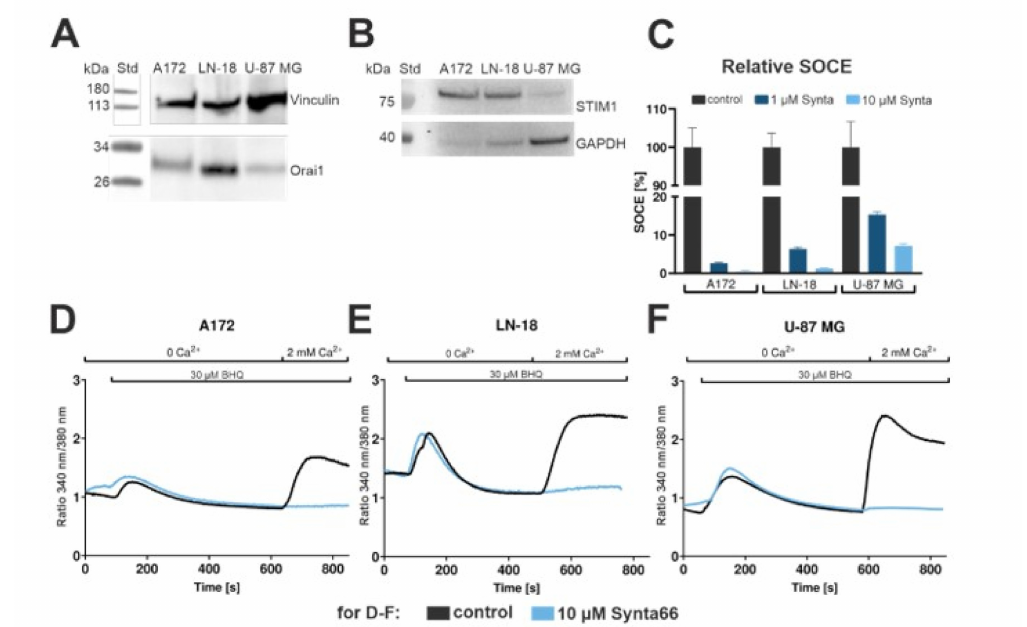
Figure6. InhibitionofSOCEinGBMcelllinesbySynta66: ( A )Westernblotfordetectionofendogenously expressed Orai1 in lysates of A172, LN-18 and U-87 MG cells. Lysates were deglycosylated in order to achieve a single Orai1 band as in [51]. ( B ) Western Blot for detection of endogenously expressed STIM1 in lysates of A172, LN-18 and U-87 MG cells. ( C ) Normalized maximal values of SOC activation from Fura-2 AM loaded GBM cells (A172, LN-18 and U-87) and comparison to SOC treated with 1 and 10 µ M Synta66 (light and dark blue, respectively). Results shown as mean ± SEM from two independent experiments (n = 109–192 cells). A172 and LN-18 had no detectable SOCE peak, U-87 MG had 7.0 ±